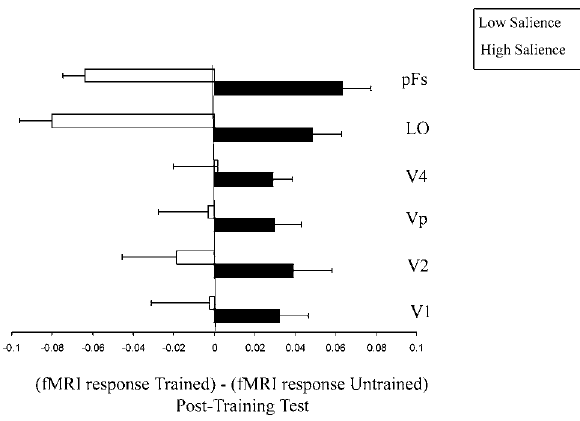
Figure 5. Summary of Results fMRI learning effects for low-salience (Experiment 1) and high-salience (Experiment 2) shapes indicated by subtracting the fMRI responses for untrained from those for trained stimuli in the post-training session in each experiment. Error bars are plus or minus the SEM. Positive values indicate stronger fMRI responses for trained stimuli, whereas negative values indicate stronger fMRI responses for untrained stimuli. DOI: